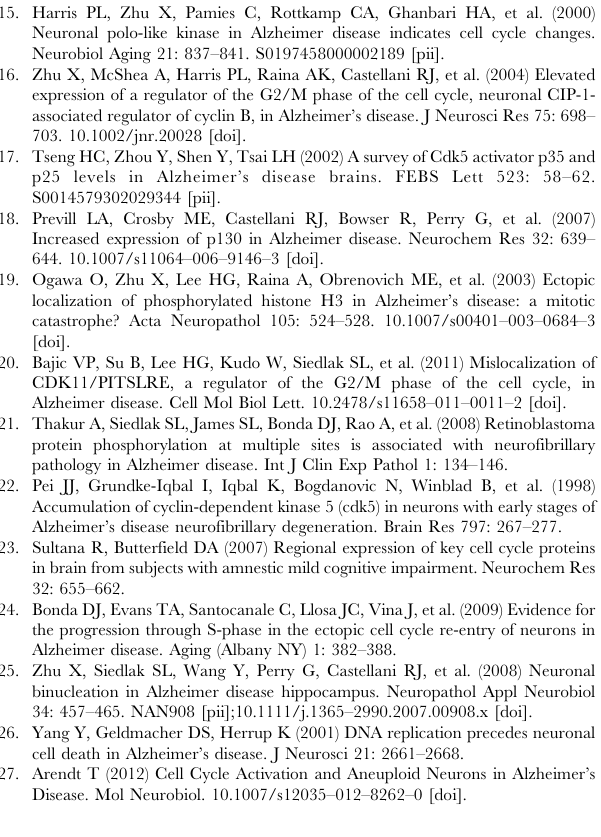
Table S1 Controls and AD groups’ classifications for